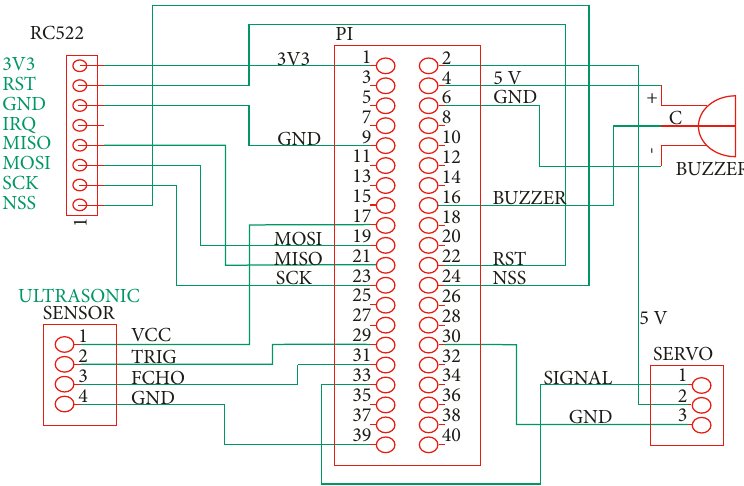
Figure 3: Hardware wiring for the